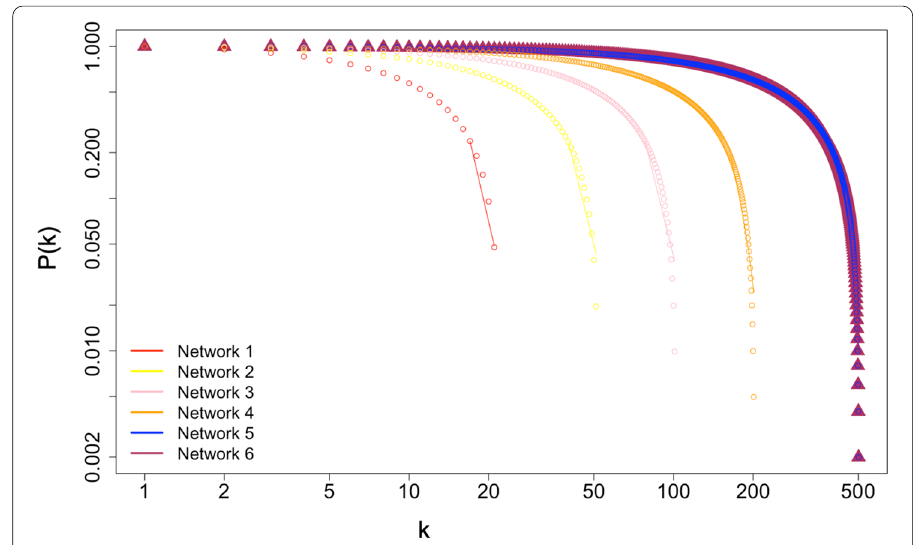
Fig. 9 A power law distribution for the community size of artificial networks with sizes ranging from 200 to 10000. The parameter values are the same as those in the violin plot in Fig. 8